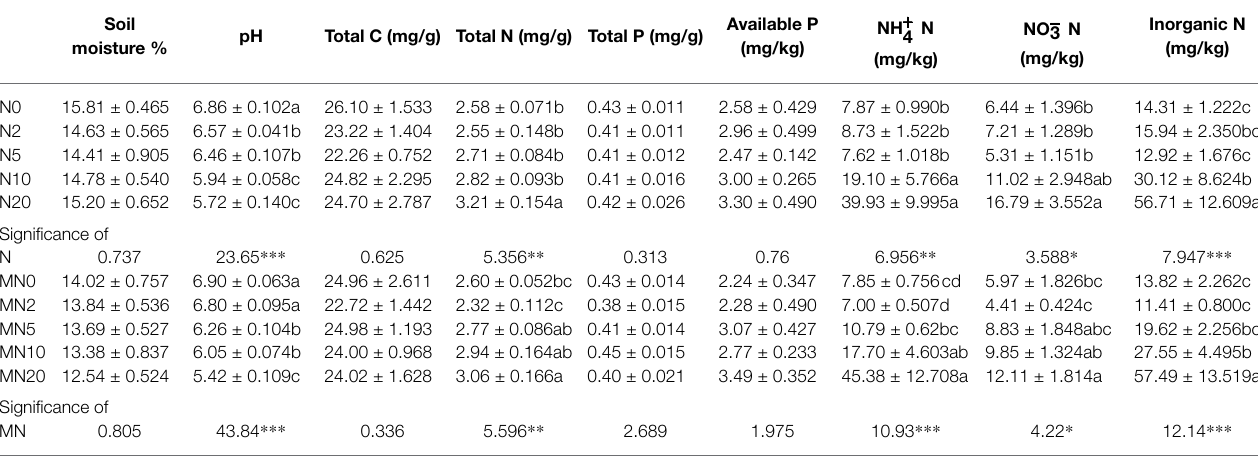
TABLE 1 | Soil properties tested by one-way ANOVA in N and MN treatments [results are means ± SE, n = 5, except + NH N 4 , summary of results of ANOVA ( F -values and significance